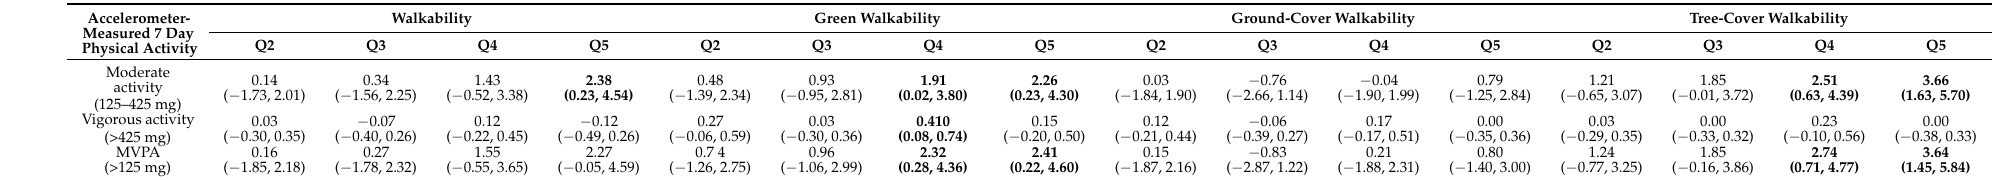
1 Reference category low physical activity group derived from the International Physical Activity Questionnaire (IPAQ). 2 Reference category did not achieve UK physical activity recommendations (>150 MET minutes per week) derived from IPAQ responses. Table 3. Effect estimates and 95% confidence intervals (CIs) for physical activity levels across quintiles of walkability scores, with quintile 1 (Q1) being the lowest 20% of a walkability score; quintile 5 (Q5) being the highest ( n = 12,986). Effect estimates are presented as additional time in minutes spent participating in moderate physical activity, vigorous physical activity and in moderate-and-vigorous physical activity (MVPA), compared to the time (minutes per day) spent participating in those activities for participants residing in the reference category of walkability (Q1; lowest walkability). Models were adjusted for: age, sex, average household income before tax, and area-level deprivation. Bold font indicates p ≤